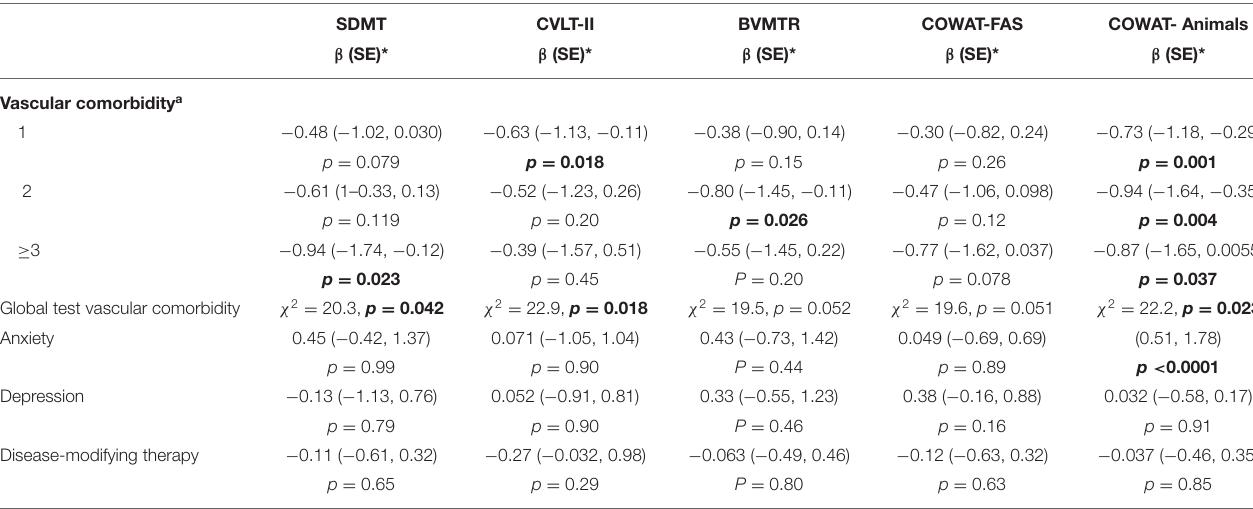
TABLE 3 | Association of vascular comorbidity with individual cognitive tests. SDMT CVLT-II BVMTR COWAT-FAS COWAT-